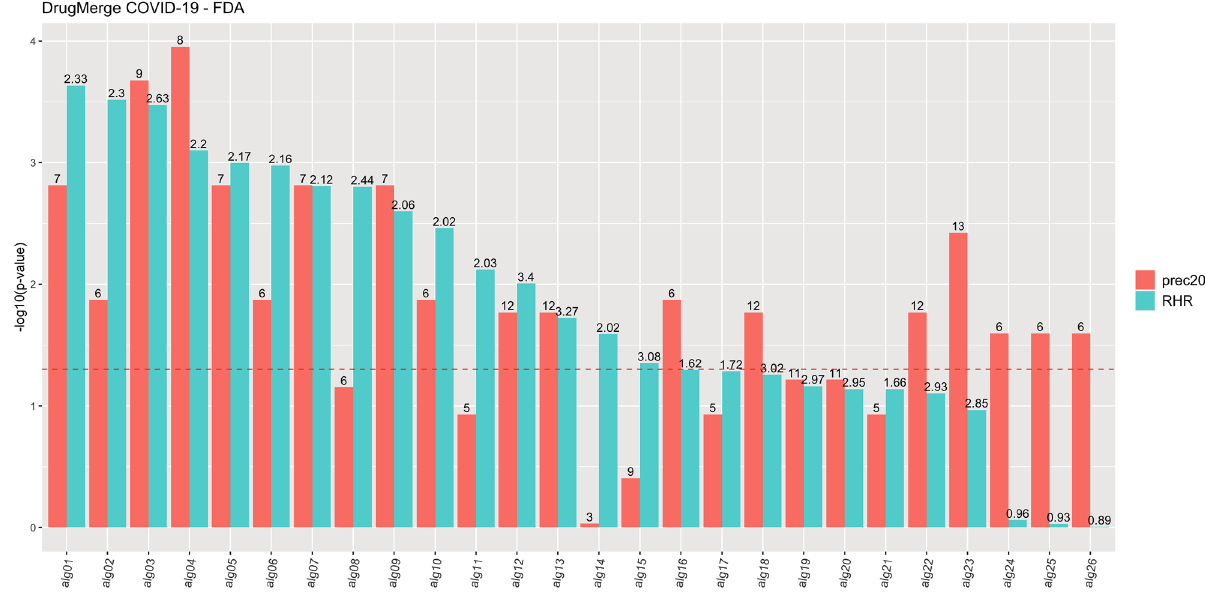
Figure 5. DrugMerge performance on COVID-19 data restricted to drugs with FDA approval. The bars represent the − log 10 ( p value ) with respect to the precision 20 (red), and the RHR (light blu). On the x-axis, different algorithms or combinations of them are indexed with aliases, since the complete algorithm names are too long. The mapping between them is on Table S9. The numbers on the top of the bars show the absolute values of precision@20 or RHR. The dotted red line represents the limit of significance ( − log 10 ( 0.05 ) ). All the bars above the dotted line show a significant p-value. The plot has been generated by the ggplot2 81 R package.